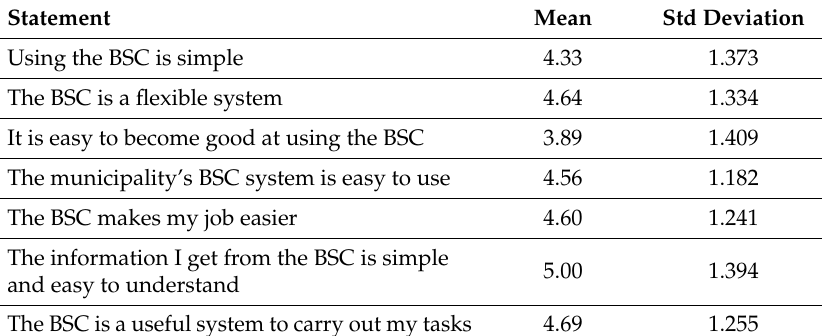
Table 22. User-friendliness (N = 36) [Scale: 1–7].